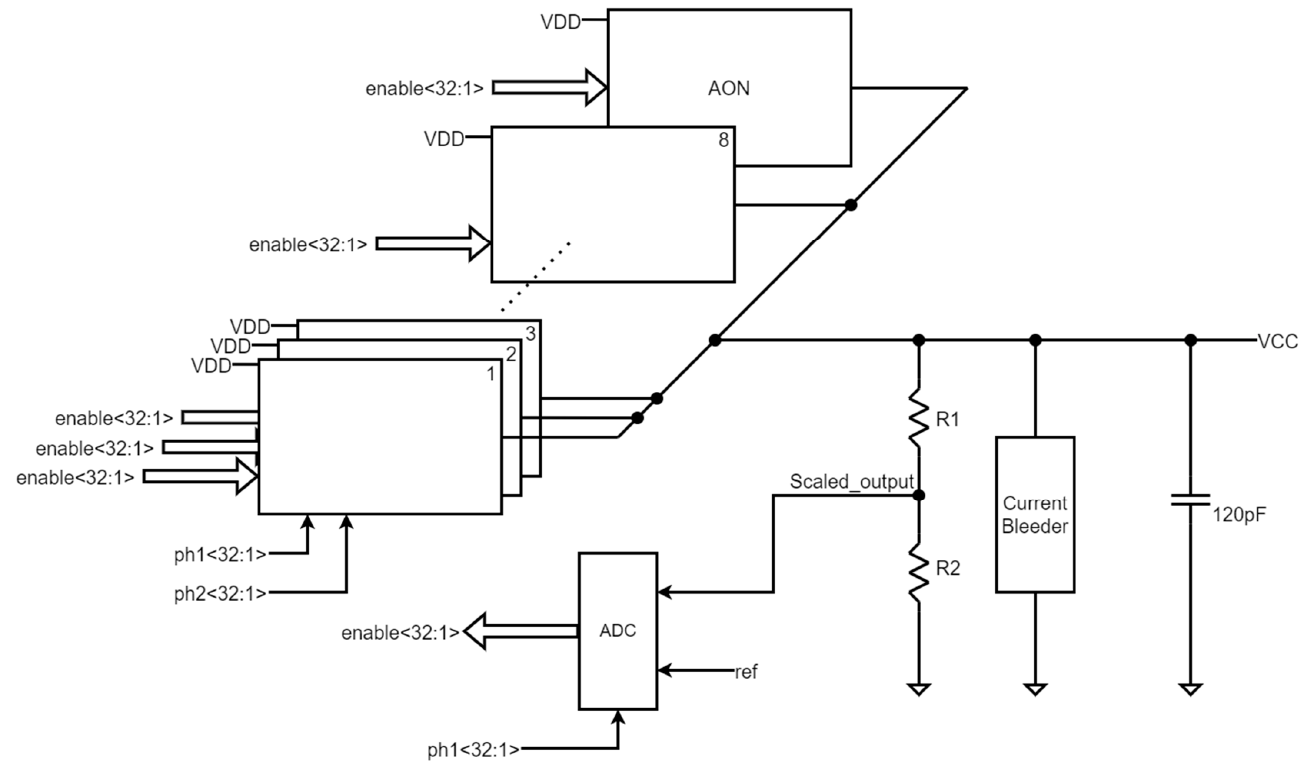
Figure 2. The proposed system.